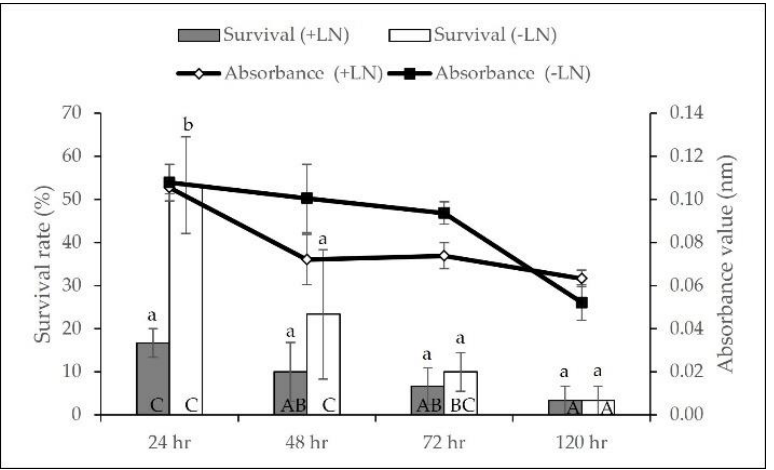
Figure 2. Effect of preculture duration in a 0.2 M sucrose on the viability of cryopreserved (+LN) and non-cryopreserved (-LN) axillary buds before dehydration and LN immersion. Error bars represent standard errors. Means with different letters (upper case: Absorbance; lower case: Survival) are significantly different based on Duncan Multiple Range Test (DMRT) at p ≤